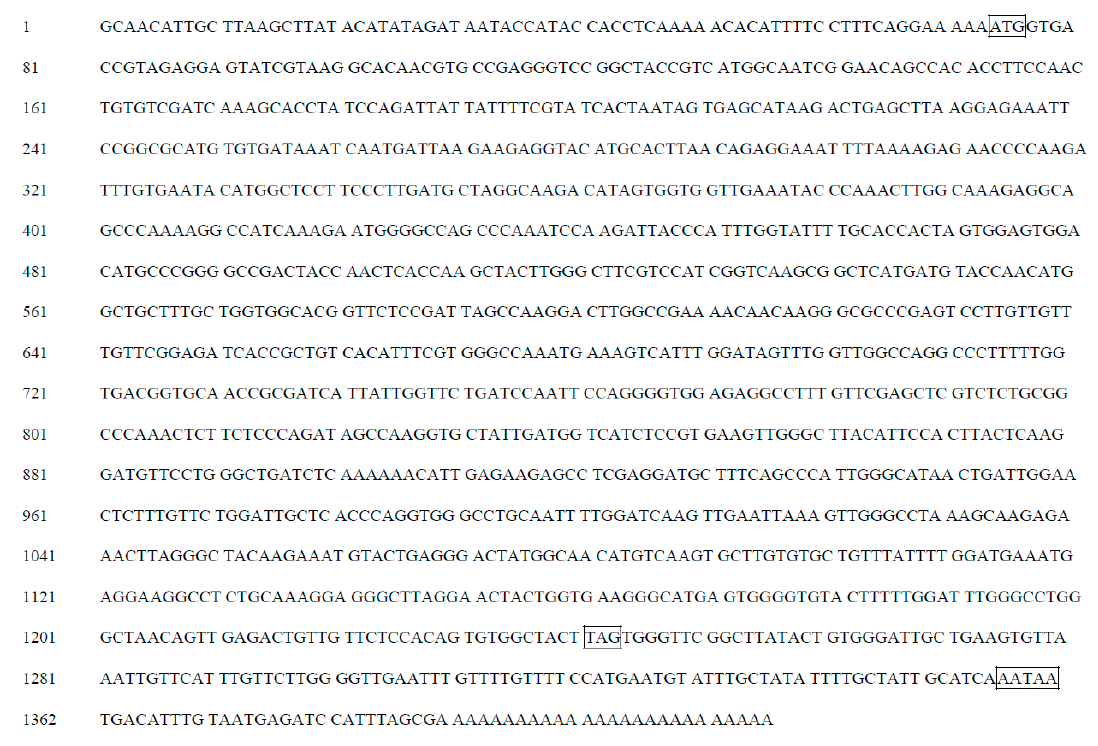
Figure 3. Full length of the sequence of CHS cDNA. ATG is start codon; TAG is stop codon; AATAA is the polyadenylation signal. The sequence contain 73 bp 5 ′ UTR and 173 bp 3 ′ UTR, with a 1170 bp open reading frame. The base the third left start codon, and the one following start codon is A and G respectively, which is obey the Kozak sequence.